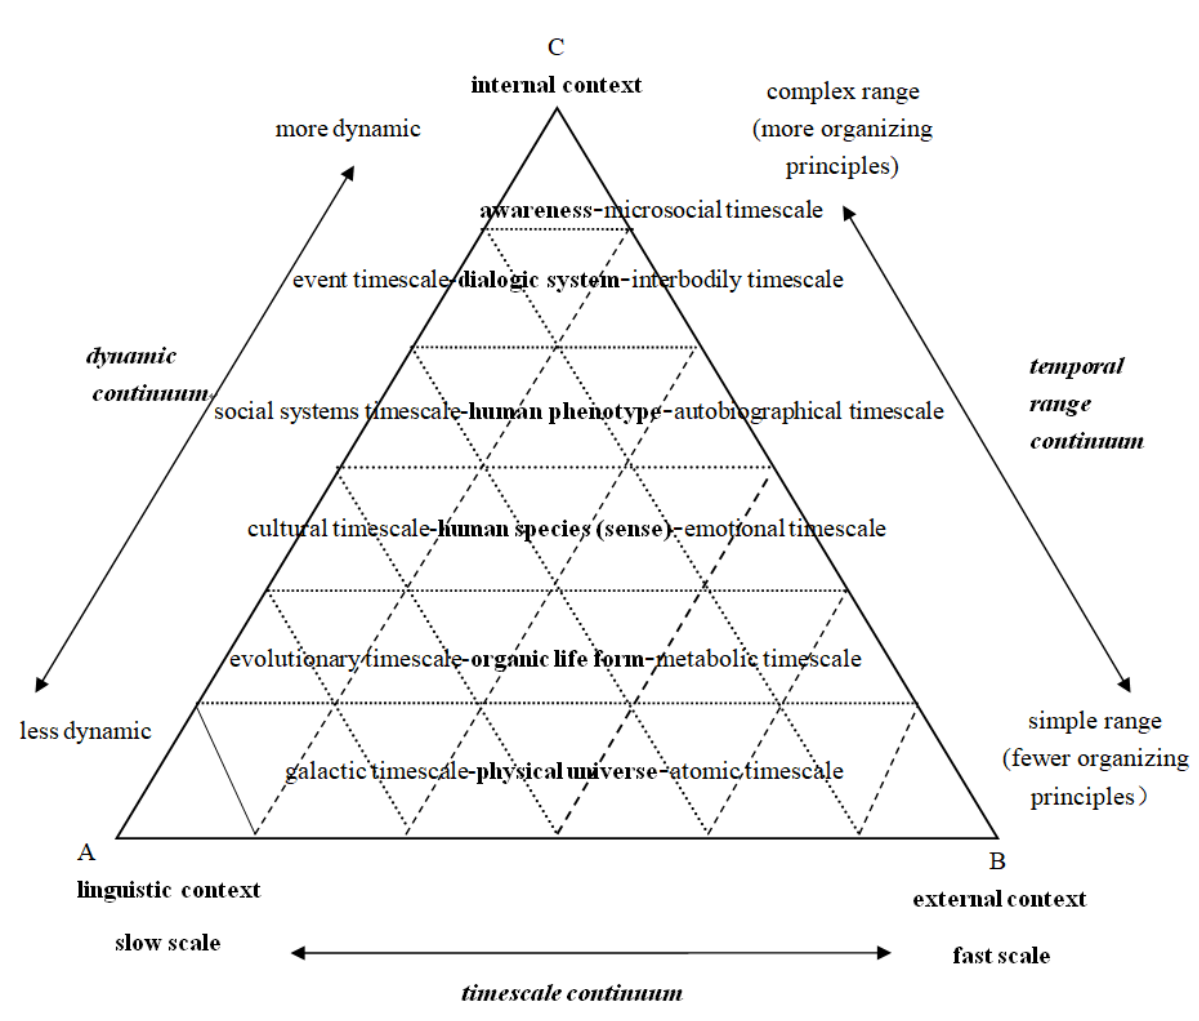
Figure 2. Tiered triangular network in interactive